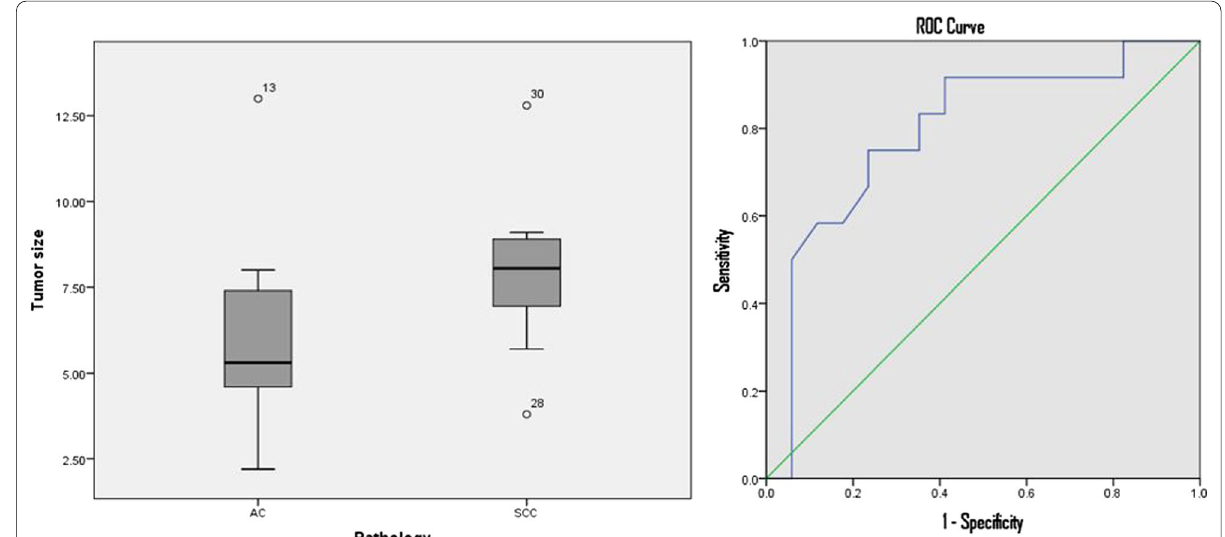
Fig. 1 Comparison of tumor size (Max diameter) of the lesion between AC and SCC. Also, the ROC curve of the size of the lesion concerning the histopathology of the lesion